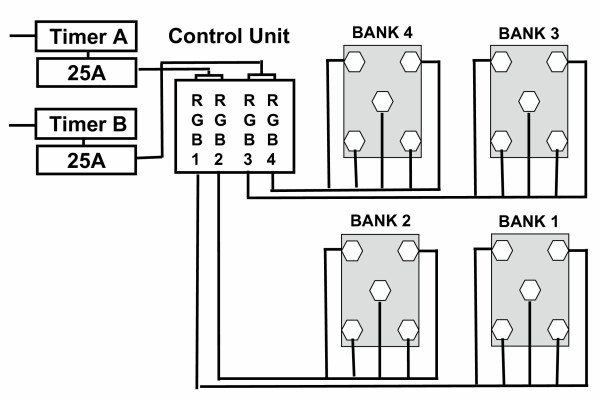
A simplified diagram of Design 1. Here 20 Norlux HEX arrays are configured into four individual banks of five arrays each. R, G and B are individually controllable on each bank, allowing the use of the controller to regulate light conditions over four independent light quality and quantity conditions. The four banks are regulated by two independent power supplies, actuated by two separate timers. In this configuration two separate photoperiods may be tested for any set of experimental parameters.